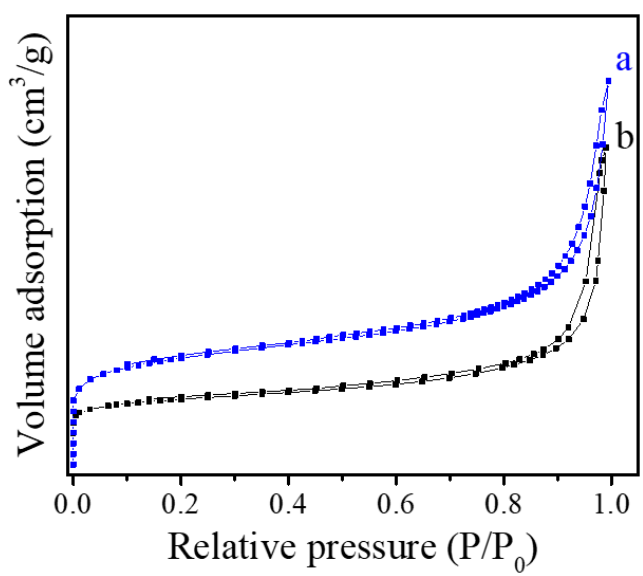
Figure 4. N 2 isotherm sorption of ( a ) Fe-LTL-N, ( b ) Fe-LTL-C. Table 1. Textural parameters of Fe-LTL samples.